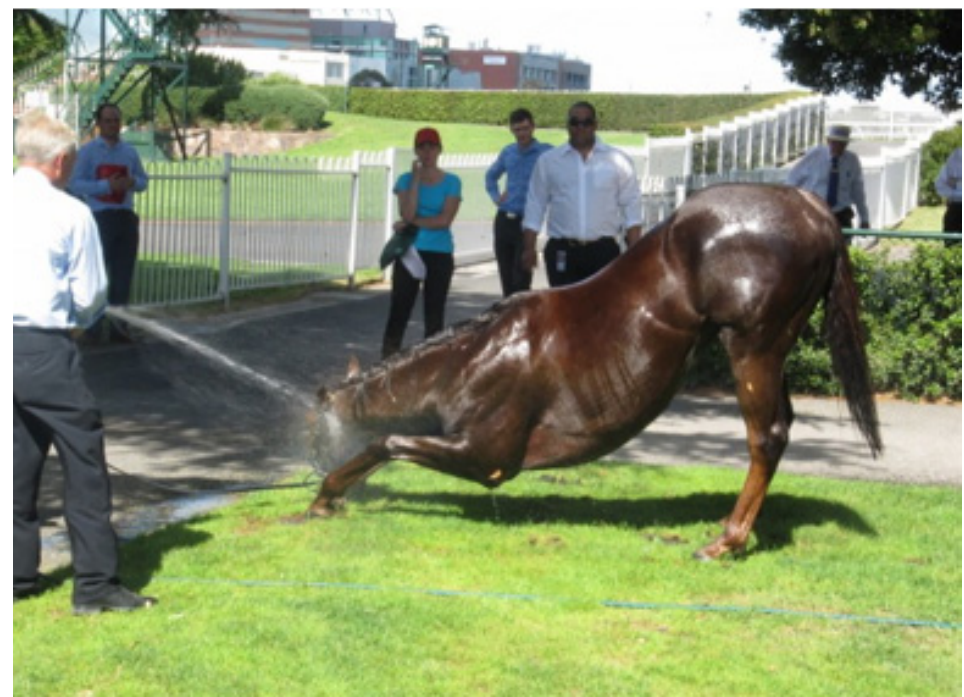
Figure 11. Level 3 EHI: Any bizarre CNS dysfunction will fit into this category. Altered mentation is characteristic and horses are described as having a ‘spaced-out’ or glassy-eyed’, ‘vacant expression’. They can also be dangerous to themselves and to their handlers. Source—J Equine Vet Ed,